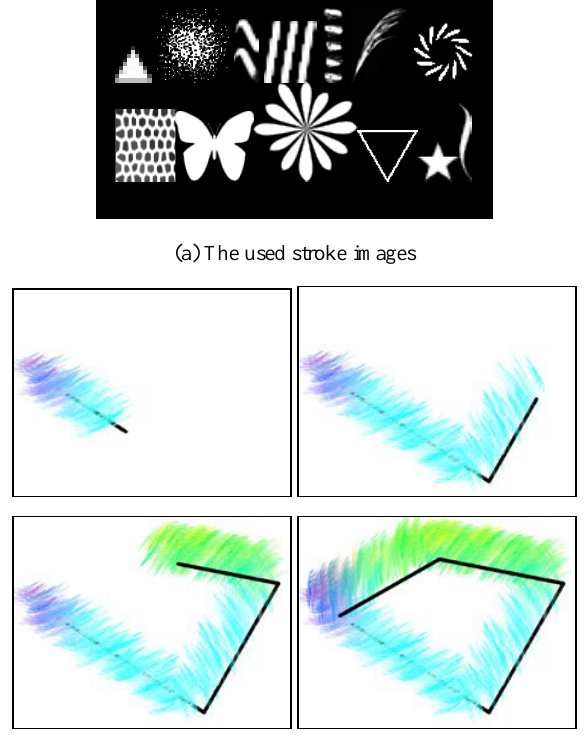
Figure 5. The rendering results using a stroke